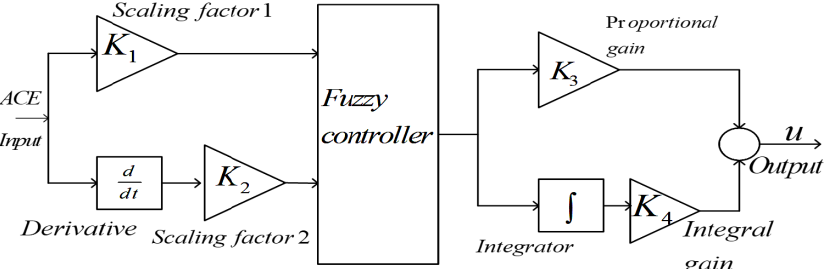
Figure 2. Proposed fuzzy PID controller structure.